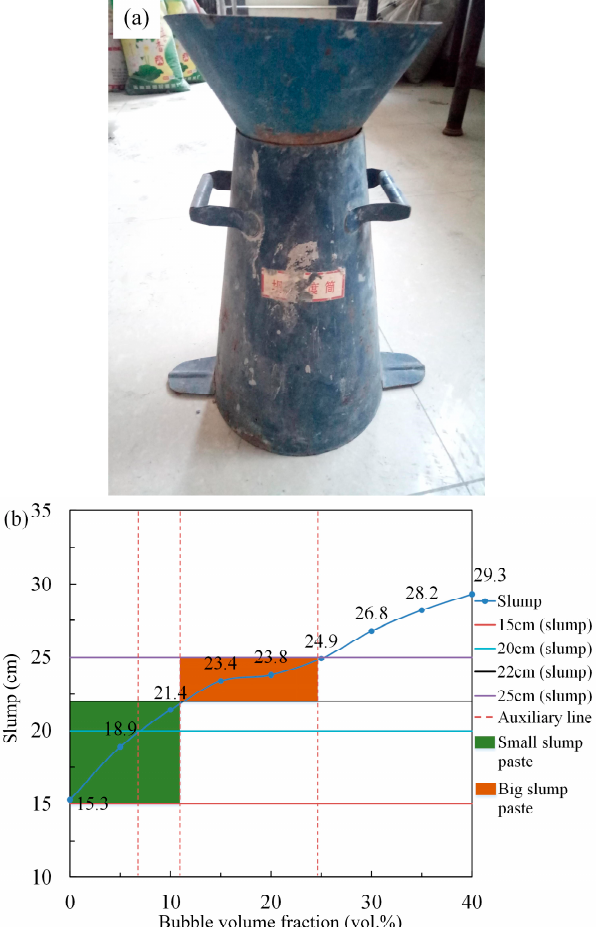
Figure 6. Slump tests: ( a ) method and ( b ) results.